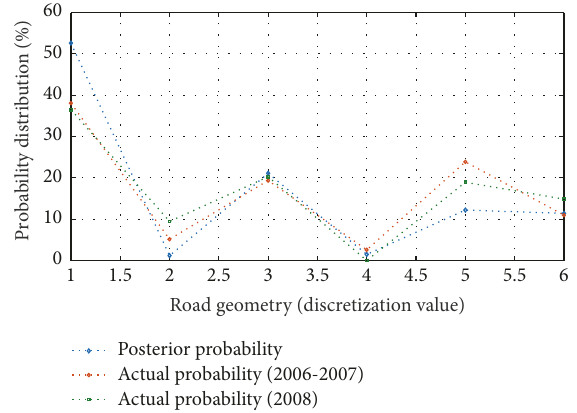
Figure 7: The comparison of posterior and actual probability curves of road geometry when the evidence variable is “rear